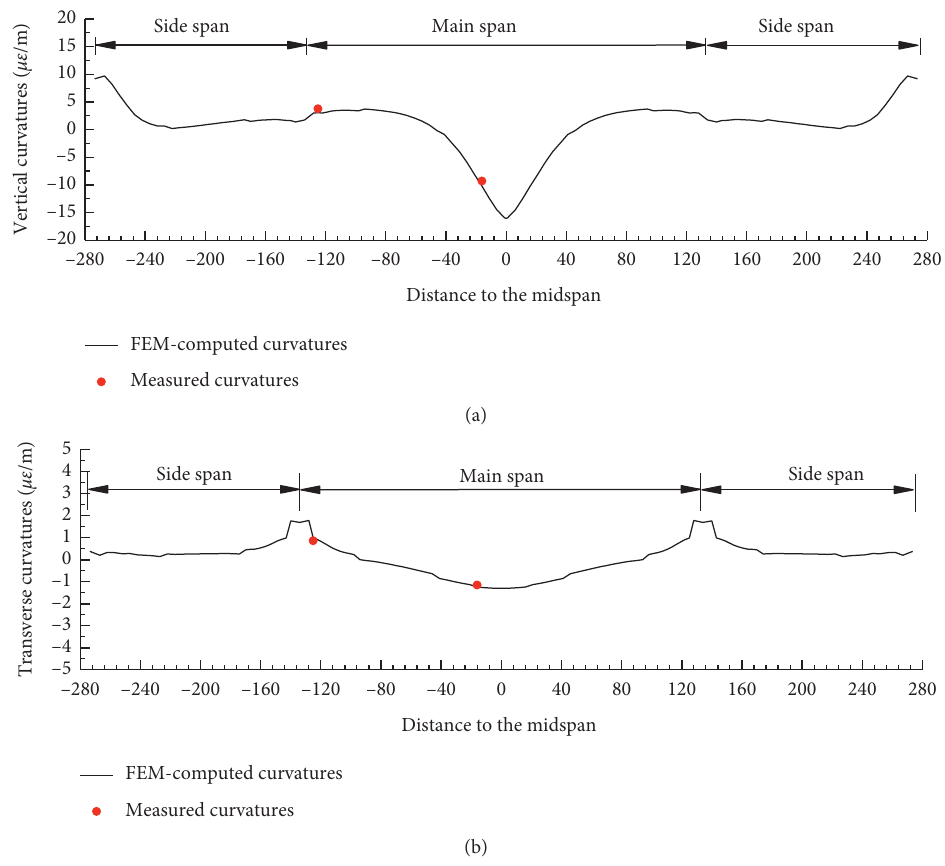
Figure 19: Comparisons of the measured and FEM-computed curvatures: (a) vertical curvatures and (b) transverse curvatures.